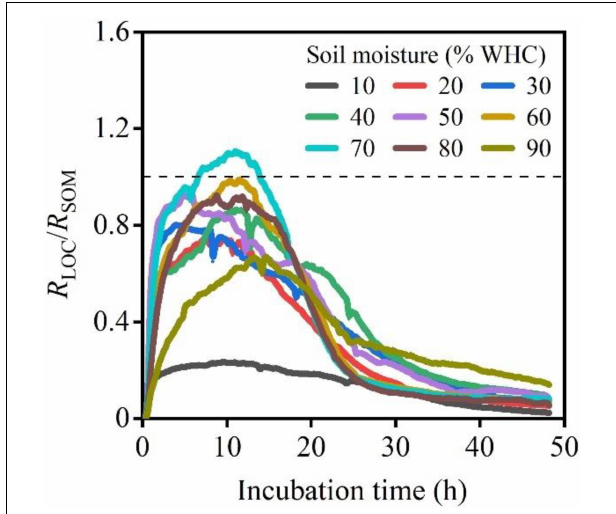
FIGURE 4 | The ratio of R LOC /R SOM under different soil moisture treatments following LOC addition. The dotted line represents R LOC = R SOM , indicating equal respiration rates of microbes using LOC and native SOM.